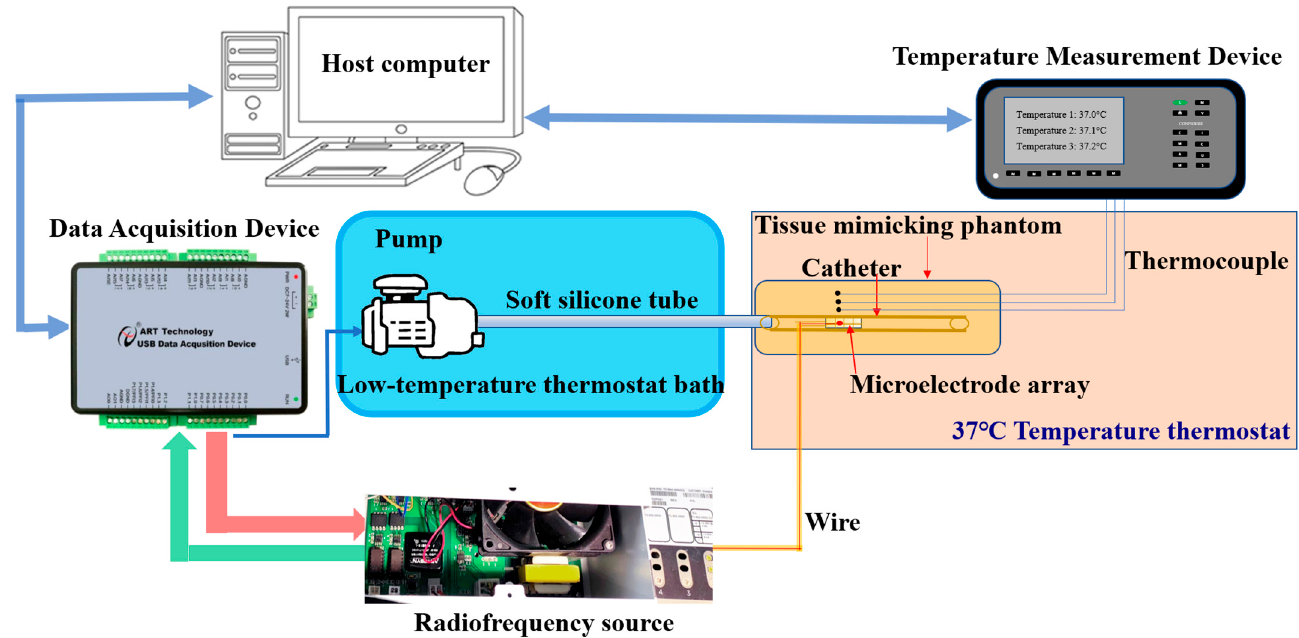
Figure 2. Illustration of the tissue-mimicking phantom heating experiment. The radiofrequency catheter system consisted of an RF source and a microelectrode array, The cooling unit (an adjustable pump and a low-temperature thermostat bath), the control unit (DAQ and host computer), and the tissue-mimicking phantom were immersed in a 37 °C thermostat bath. A temperature measurement device connected to the host computer was used to measure, display, and record the temperature. Three calibrated temperature sensors (TC1, TC2, and TC3) (K-Type